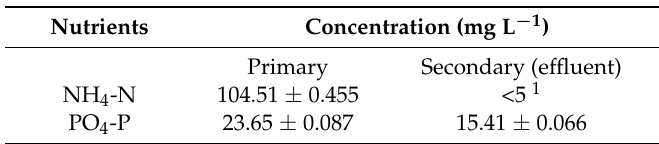
Table 1. Nutrient concentration of autoclaved primary and secondary domestic wastewater from the Southgate